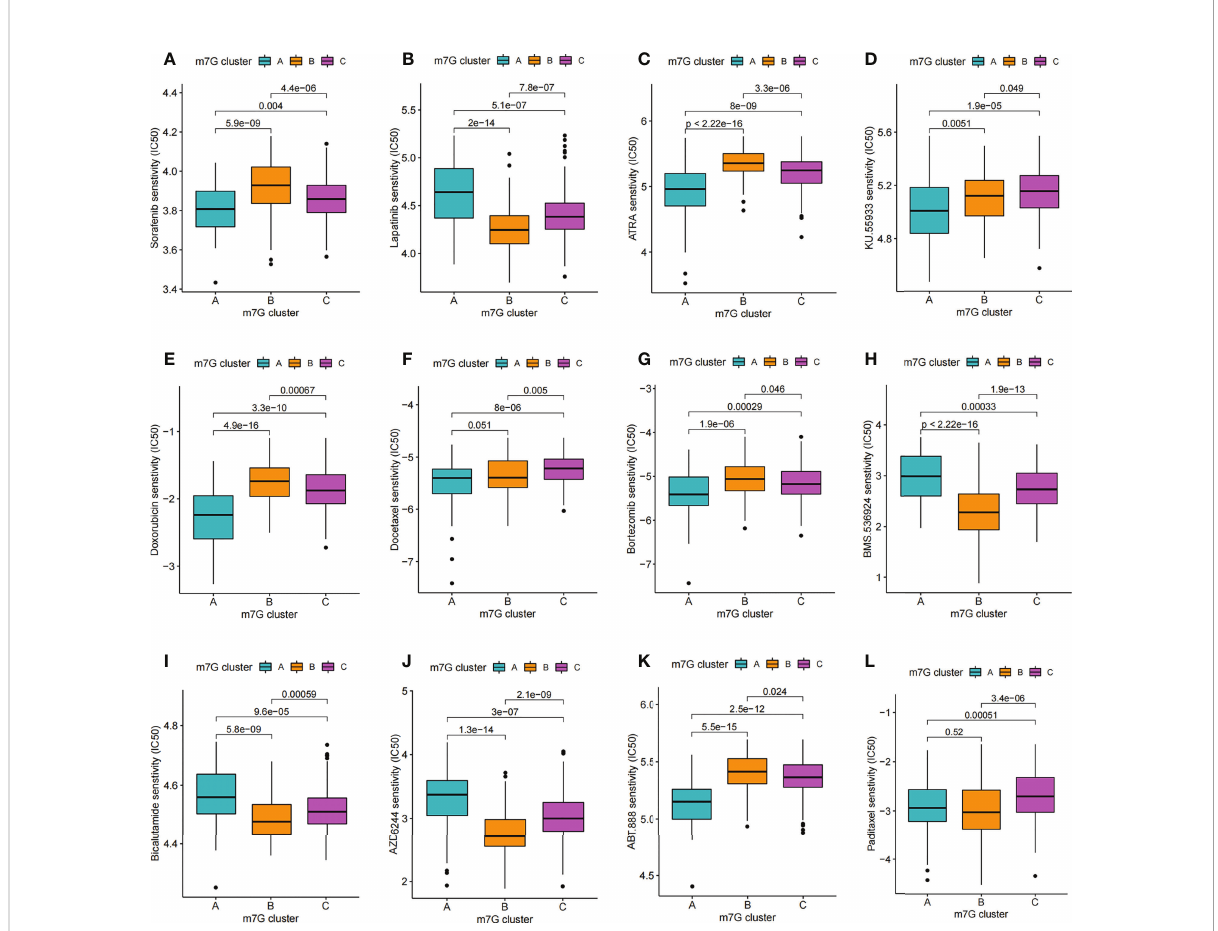
FIGURE 9 Comparison of drug sensitivity. (A – L) Comparison of IC50 of small molecule drugs between different m 7 G